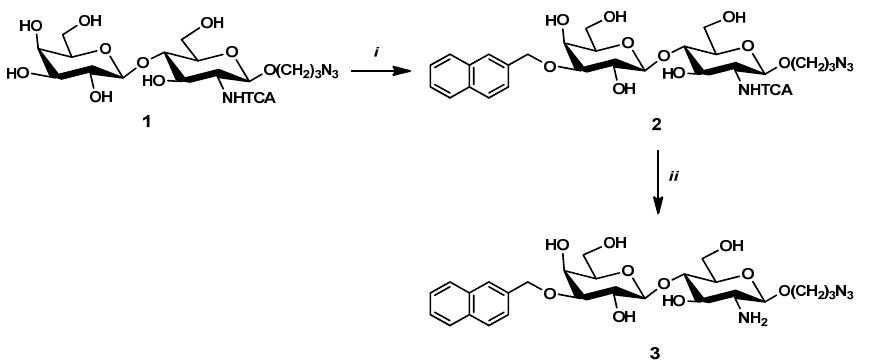
Figure 1. Reagents and conditions: (i) Bu 2 SnO, toluene, reflux, 3 h; NAPBr, CsF, DMF, rt, 24 h 85% for two steps; (ii) NaOH (0.5 M) in MeOH-H 2 O 1:1, rt, 48 h, 79%. After that, a thiourea bond was formed between the amino group of the (2-naphthyl)methylated lactosamine derivative 3 and the isothiocyanate group of p-SCN-Bn-DOTAGA ( 4 ) in a mixture of DMSO and 0.1 M sodium carbonate buffer, resulting in compound 5 (Figure 2).